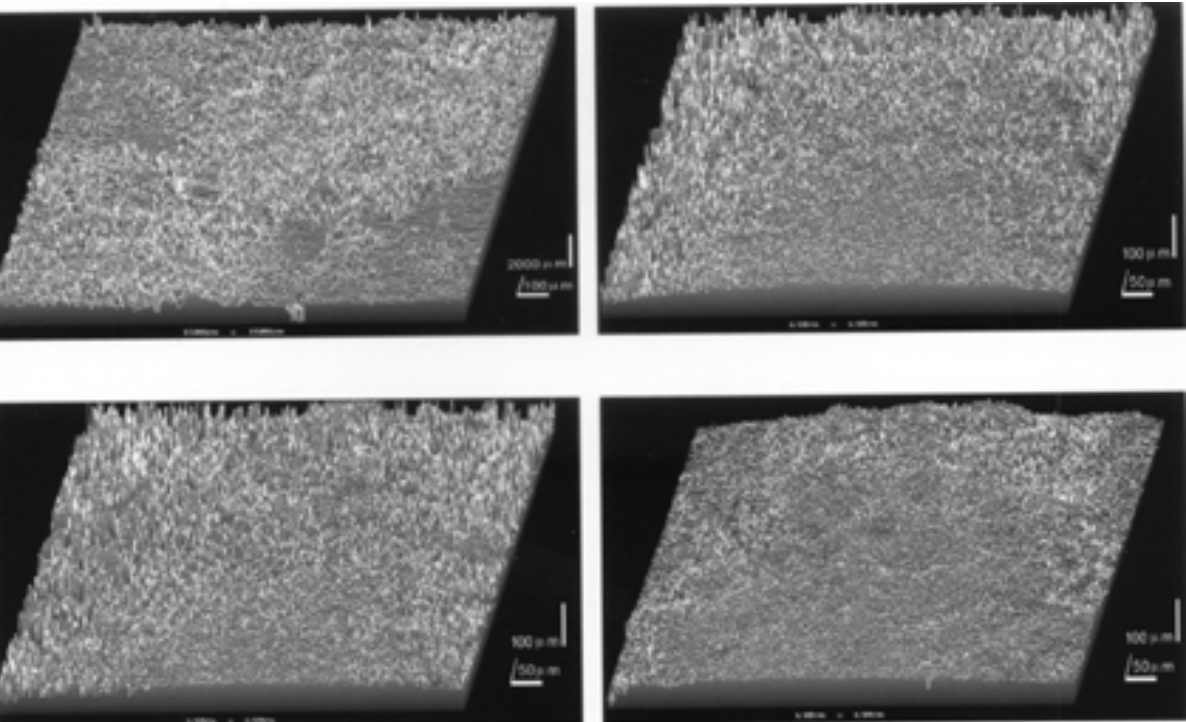
Figure 4. Topography maps for the specimens: a) as-machined; b) Al 2 O 3 blasted; c) plasma-sprayed with titanium; d) electrolytically coated with hydroxyapatite. Table 1. Roughness parameters of the analysed implants. Specimen